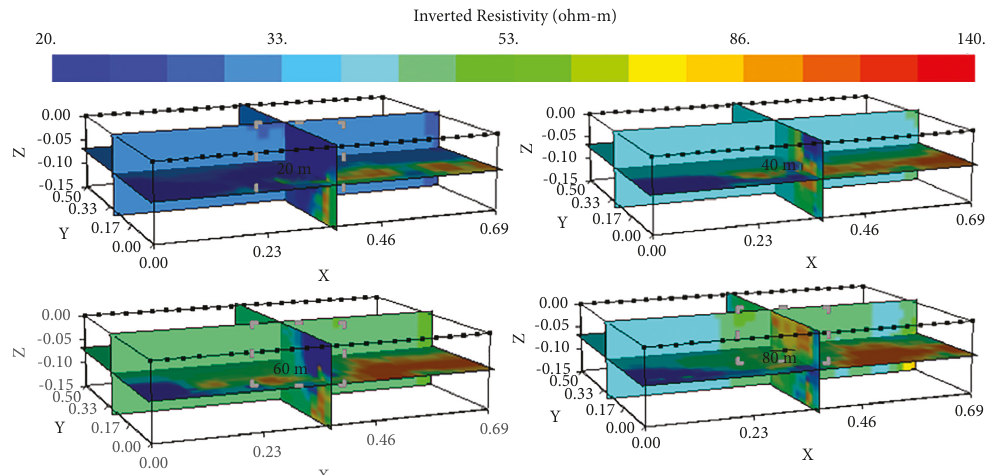
Figure 17: The resistivity section diagram of dynamic at 15cm above the coal seam.